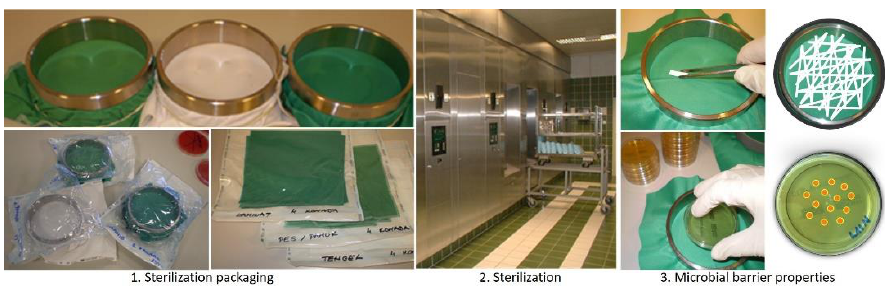
Figure 3. Microbial barrier properties.